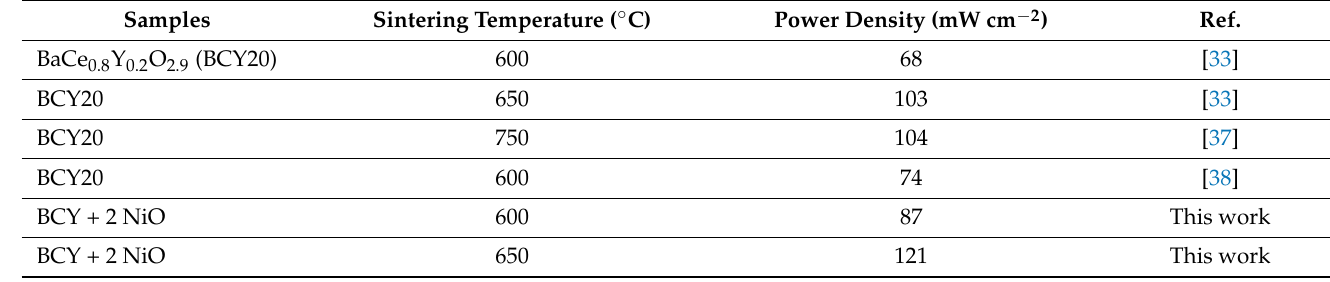
Table 1. Comparison of the power density of SOFCs based on BCY